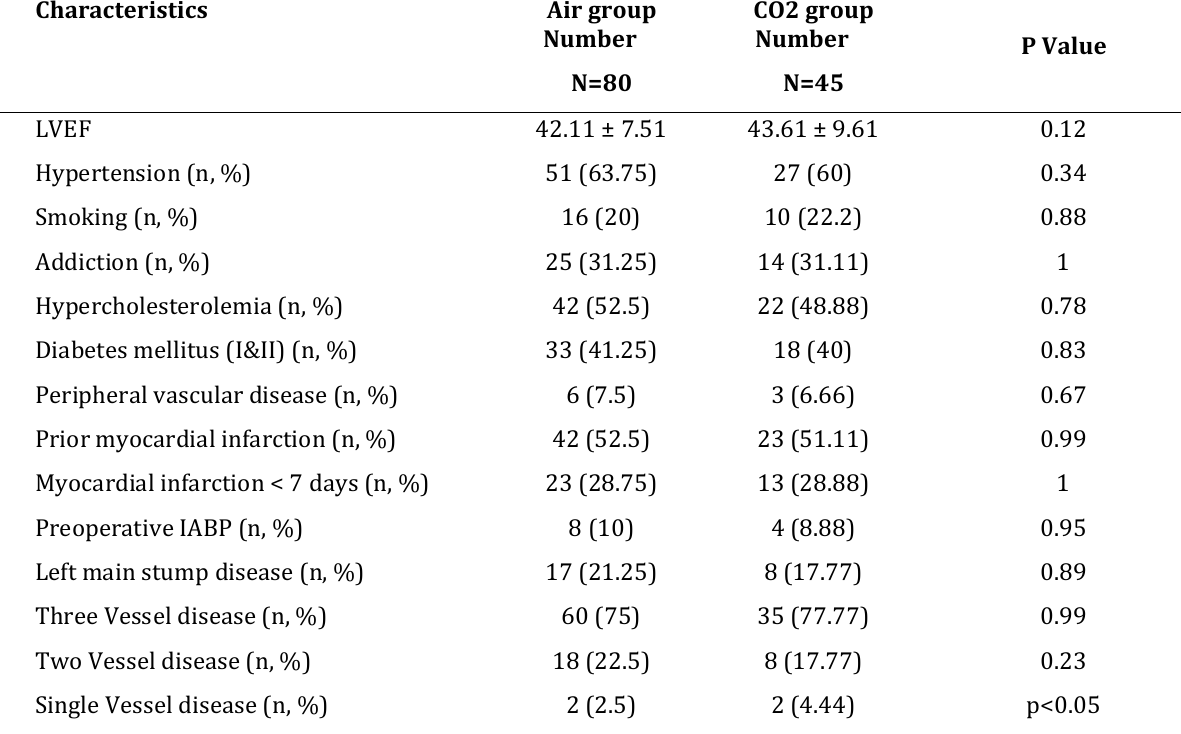
Table 1- Demographic and past medical history of patients in two groups